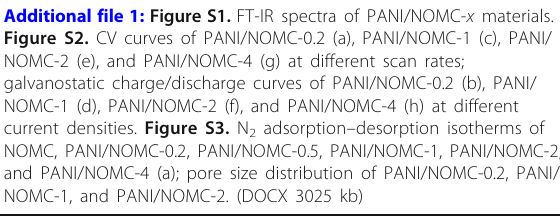
Additional file 1: Figure S1. FT-IR spectra of PANI/NOMC- x materials. Figure S2. CV curves of PANI/NOMC-0.2 (a), PANI/NOMC-1 (c), PANI/ NOMC-2 (e), and PANI/NOMC-4 (g) at different scan rates; galvanostatic charge/discharge curves of PANI/NOMC-0.2 (b), PANI/ NOMC-1 (d), PANI/NOMC-2 (f), and PANI/NOMC-4 (h) at different current densities. Figure S3. N 2 adsorption – desorption isotherms of NOMC, PANI/NOMC-0.2, PANI/NOMC-0.5, PANI/NOMC-1, PANI/NOMC-2, and PANI/NOMC-4 (a); pore size distribution of PANI/NOMC-0.2, PANI/ NOMC-1, and PANI/NOMC-2. (DOCX 3025